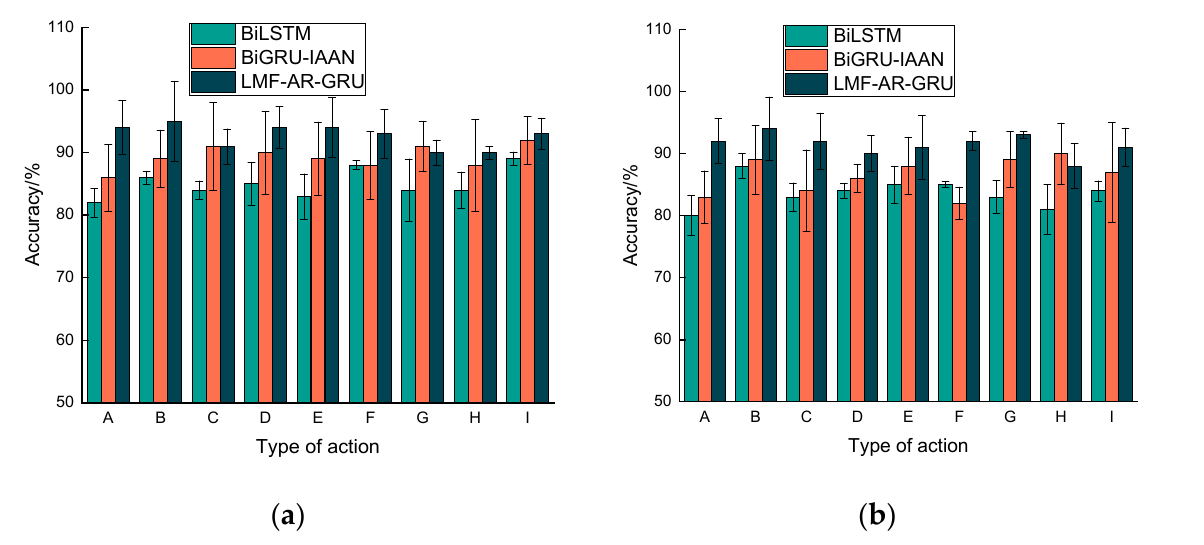
Figure 13. ( a ) Model weighted accuracy (WA) histogram; ( b ) model unweighted accuracy (UA) histogram.